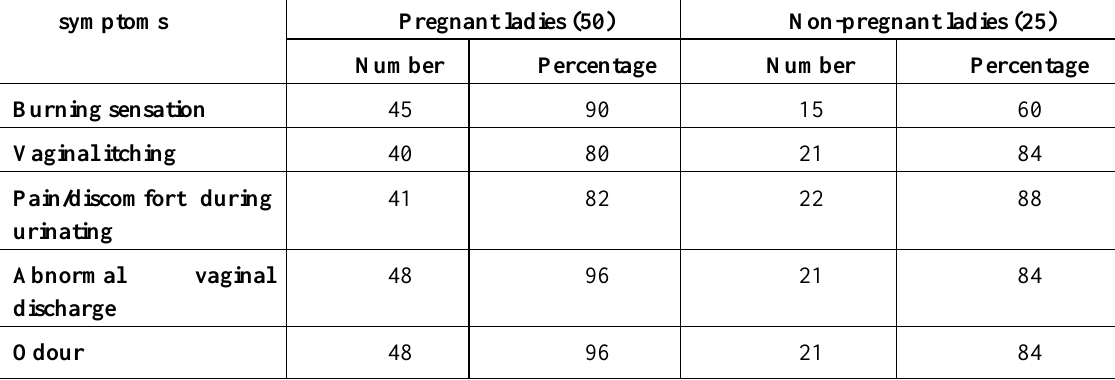
Table 3. Percentage of symptoms among pregnant and non-pregnant women with positive